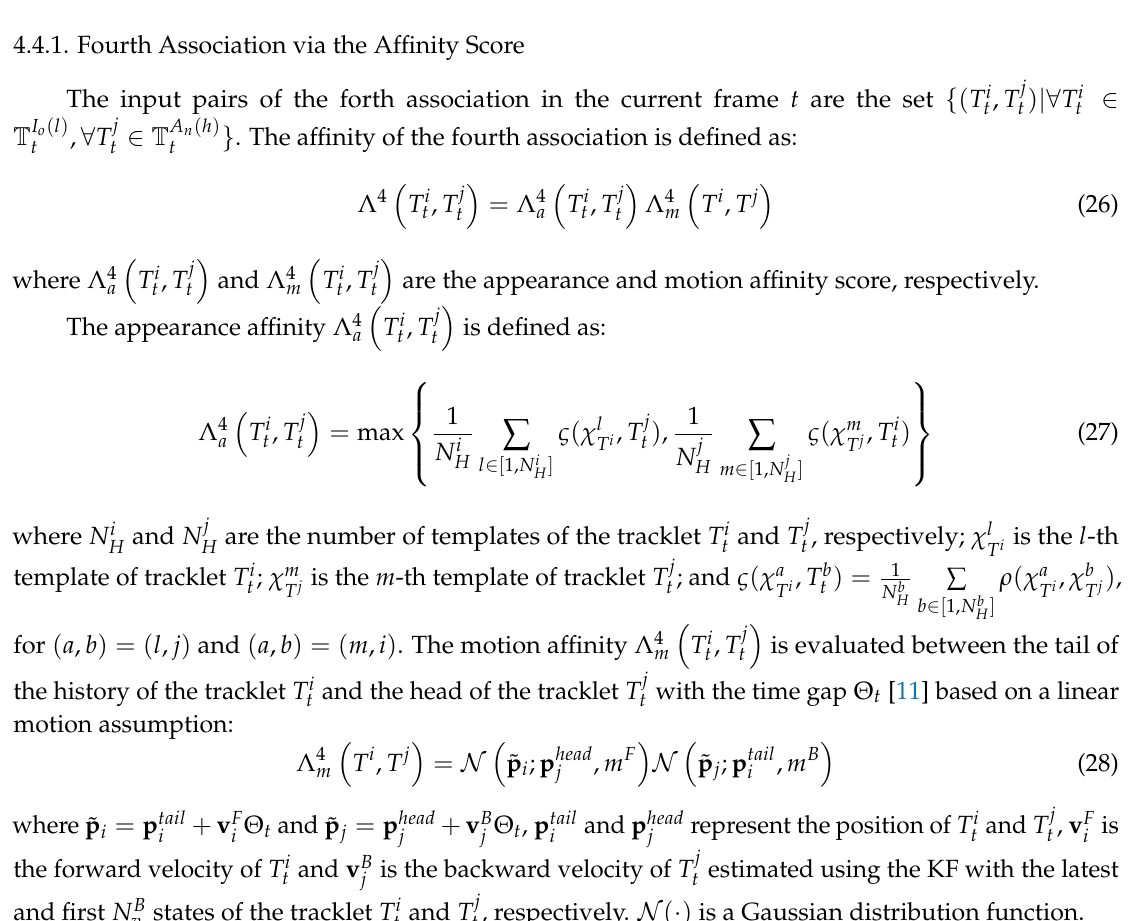
Figure 5. Fragmented tracklet under long-term occlusions. ( a ) Two tracked objects ID-3 and ID-4; ( b ) the object ID-3 is partially occluded and ( c ) heavily occluded by trees; ( d ) the lost object ID-3 is switched to ID-6 when it reappears again after the